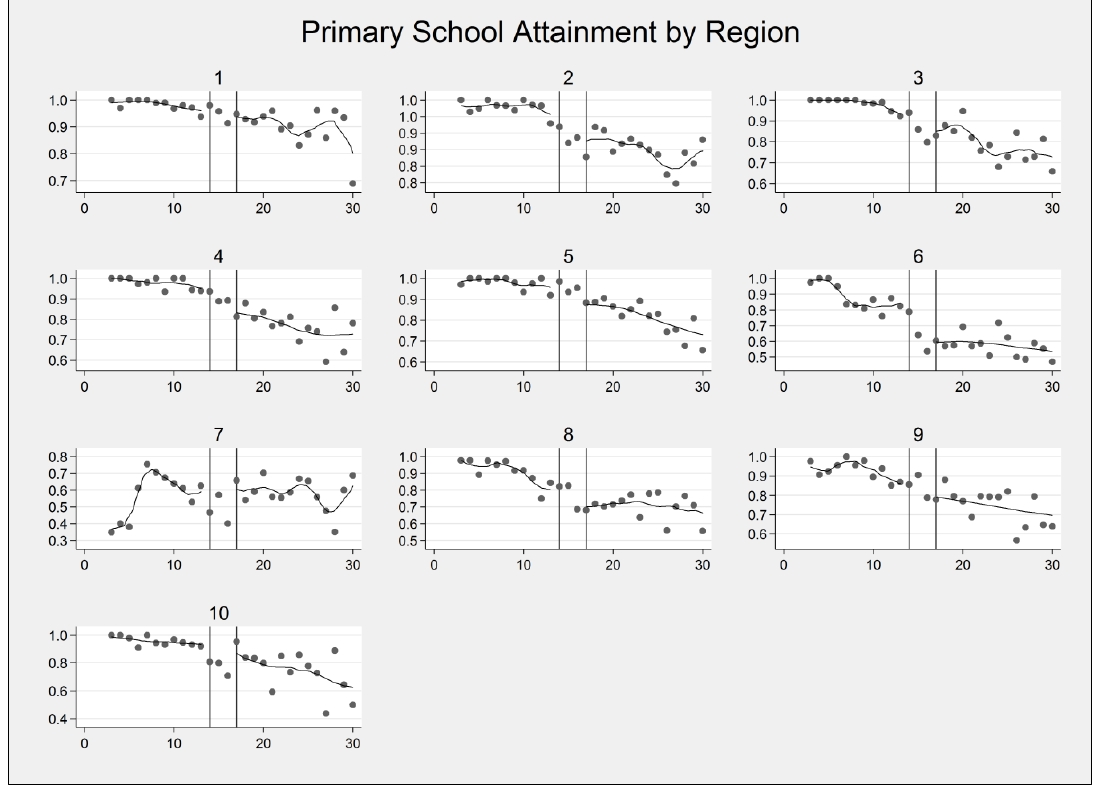
Figure 1. Primary school attainment by region of residence: Regions: 1 = Kampala, 2 = Central 1, 3 = Central 2, 4 = East central, 5 = Eastern, 6 = North, 7 = Karamoja, 8 = West-Nile, 9 = Western, 10 = Southwest. Note that the figures on the y-axis are rounded to one decimal point.